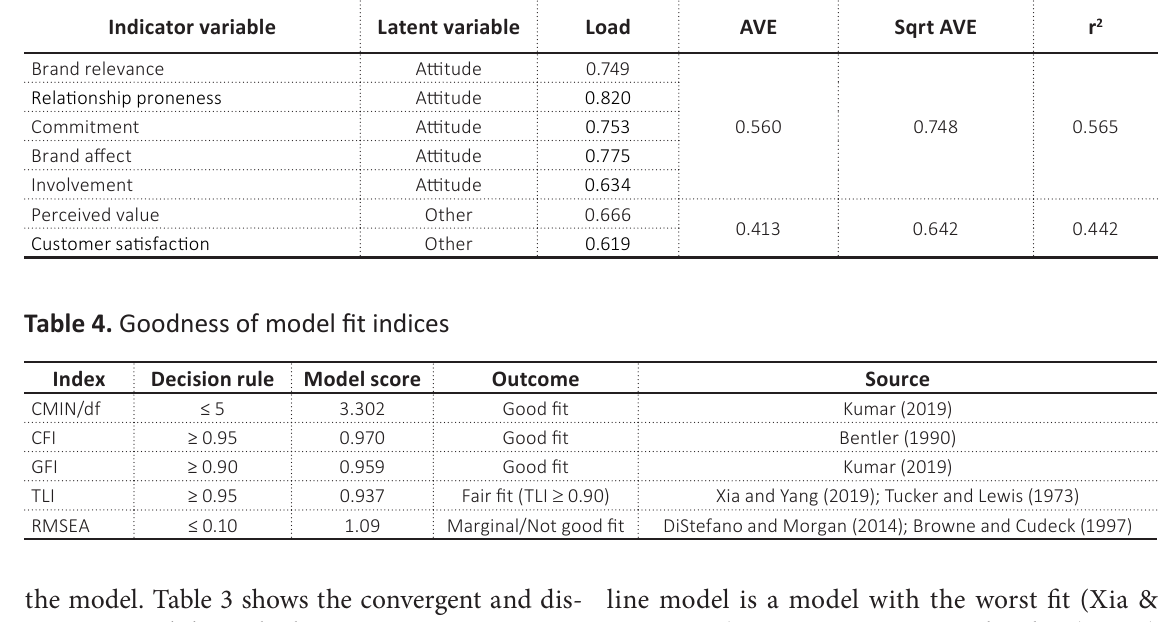
Table 3. Construct validity analysis